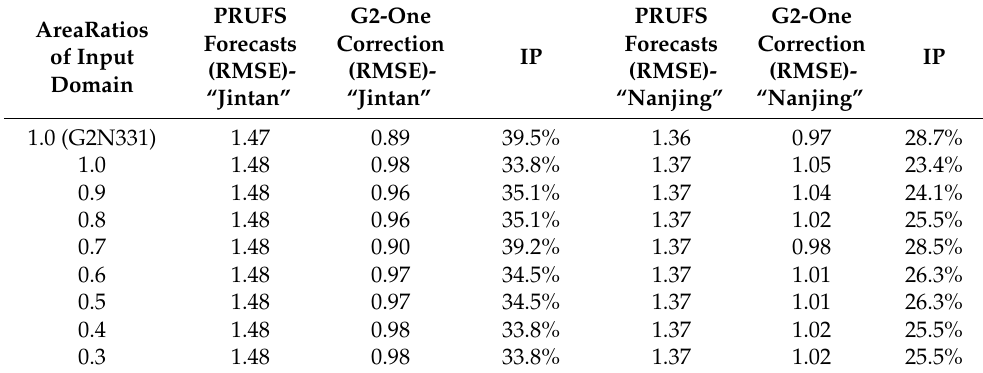
Table 2. RMSE of the 10 m wind speed of the PRUFS forecast and the correction by G2-One at Jintan and Nanjing for different input areas and the corresponding IP. The evaluation was done on all test